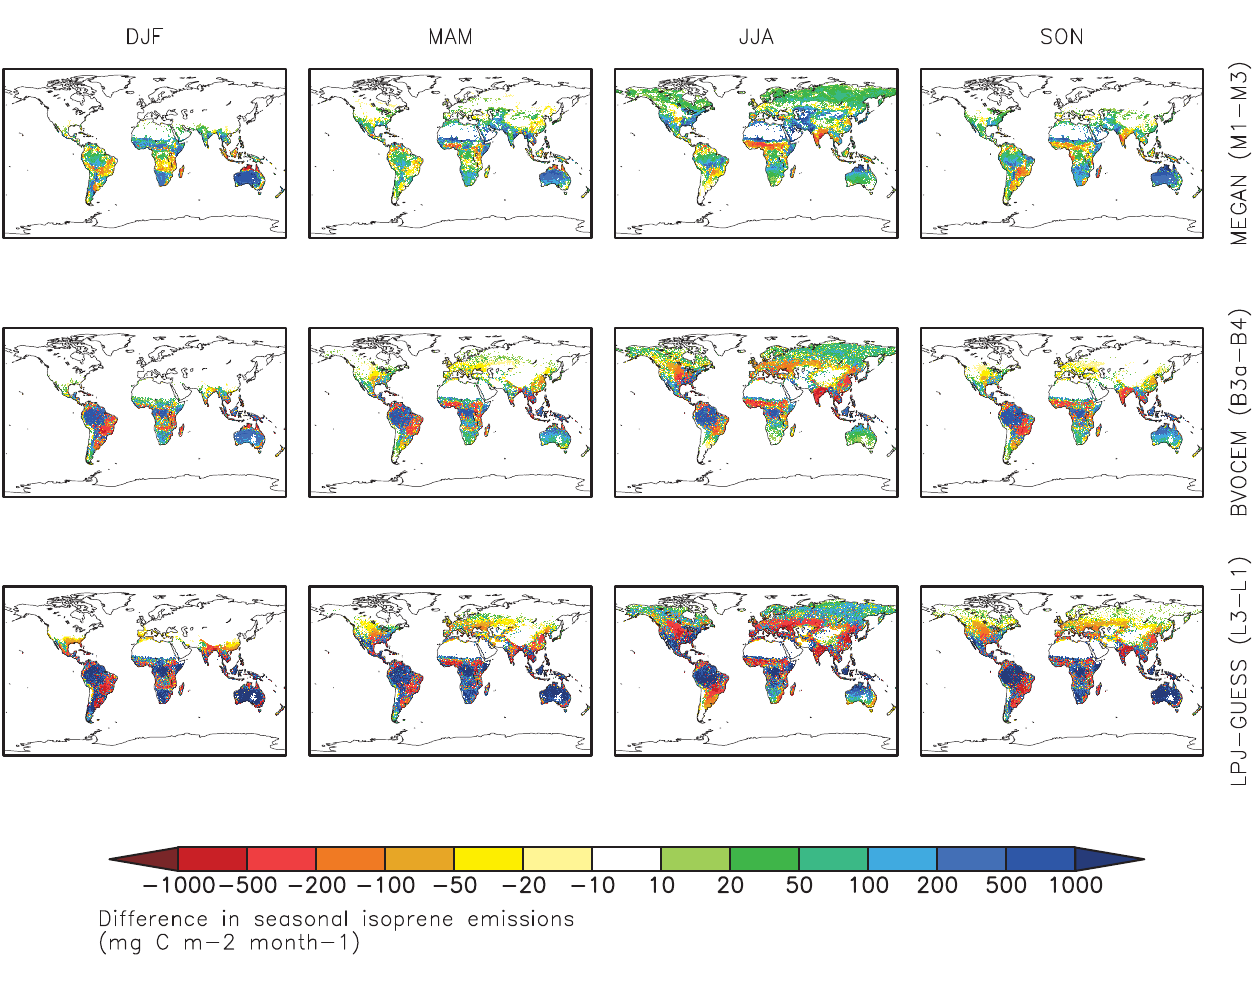
Fig. 4. Difference in isoprene emissions (mgCm − 2 month − 1 ) for simulations performed with MEGAN vegetation minus LPJ-GUESS vegetation. Panels show monthly averages over three-month periods, the same as those in Fig. 3 (top: M1–M3; middle: B3a–B4; bottom: L3–L1, see Table